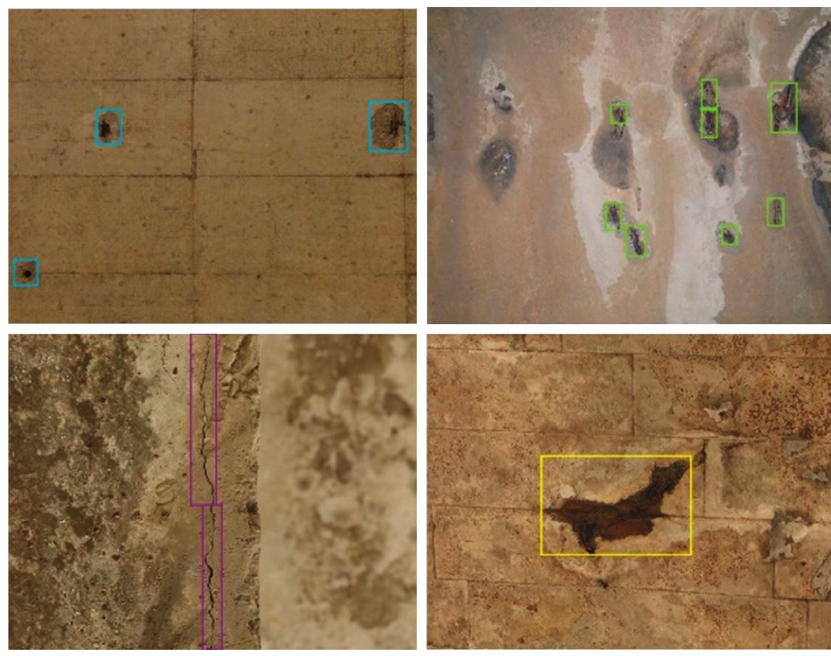
Figure 14: Annotated images in the data set. Table 15: Test result of beam bridge (tailwind, side).